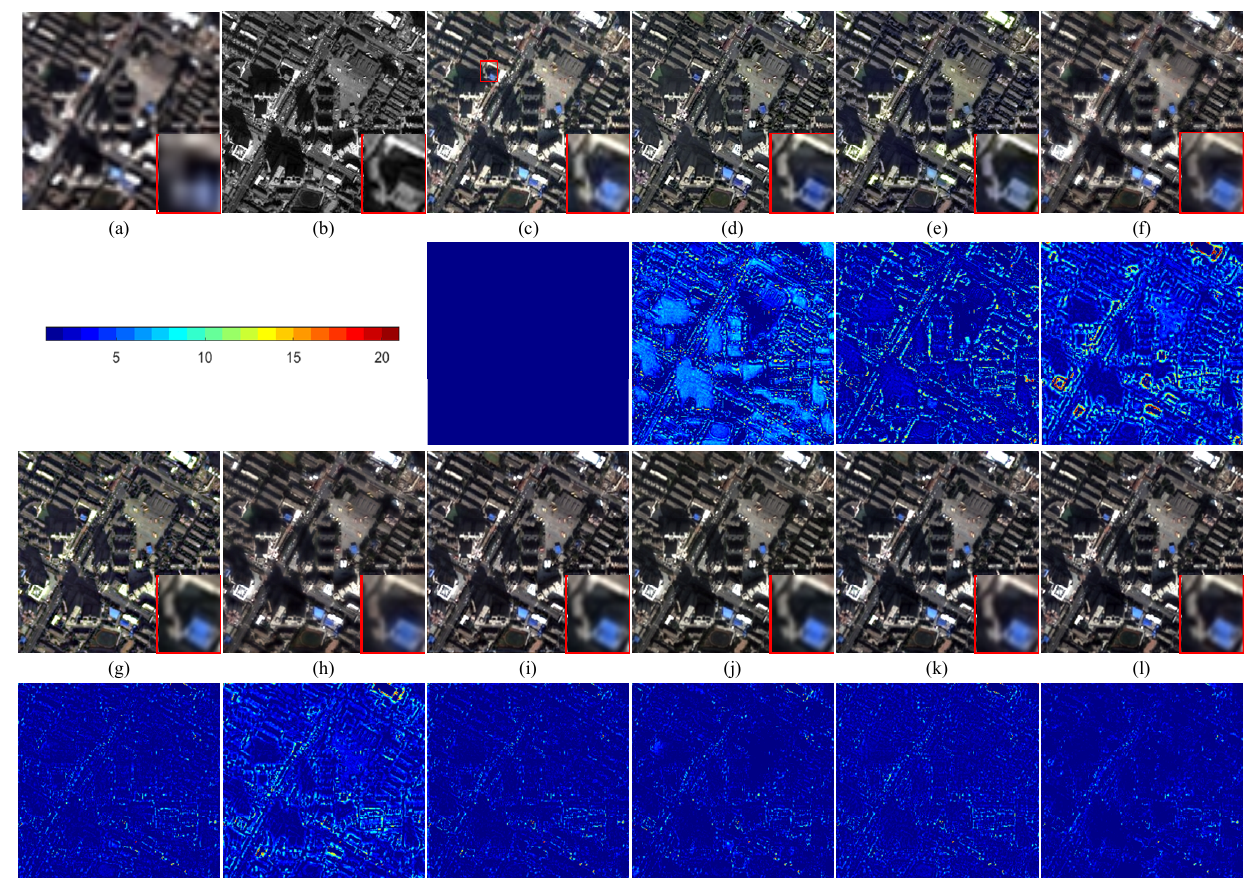
Figure 6 reflect similar performance. The errors of BDSD, VPLGC, and DRPNN are worse than those of other methods. The DNN-based methods can approximate the reference image better. However, their reconstruction performance is also limited in the edges of buildings. From the error maps, we can see that the proposed method behaves better in terms of reconstruction accuracy because more pixel values are closer to 0.